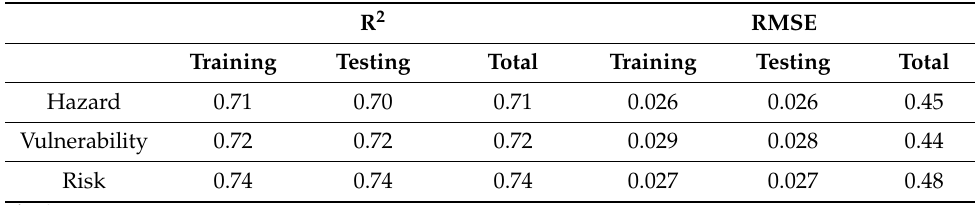
Table 4. Performance criteria for developed SVM at Level 2.